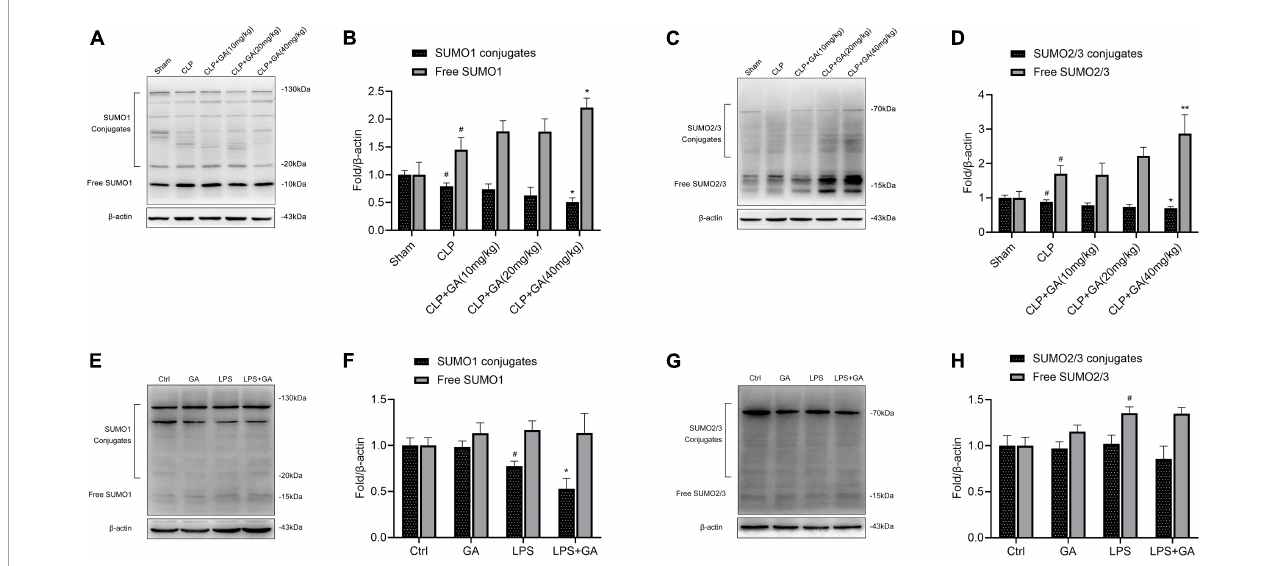
FIGURE4 SUMO1 and SUMO2/3 are downregulated in macrophages and are inhibited by ginkgolic acid (GA) in vivo and vitro . (A,C) Representative image of western blotting analysis of the levels of SUMO1 and SUMO2/3 in the peritoneal macrophages (PMs) of mice at 24 h after the cecal ligation and puncture (CLP), treated with different doses of GA. Quantification of western blotting data was shown in (B,D) . Data were calculated with the mean ± SD ( n = 3). # P < 0.05 versus the Sham group; ∗ P < 0.05, ∗∗ P < 0.01 versus the CLP group. (E,G) Representative image of western blotting analysis of the levels of SUMO1 and SUMO2/3 in RAW 264.7 cell at 24 h after the stimulation of lipopolysaccharide (LPS), treated with different doses of GA or vehicle. Quantification of western blotting data was shown in (F,H) . Data were calculated with the mean ± SD ( n = 3). # P < 0.05 versus the Ctrl group; ∗ P < 0.05 versus the LPS group.